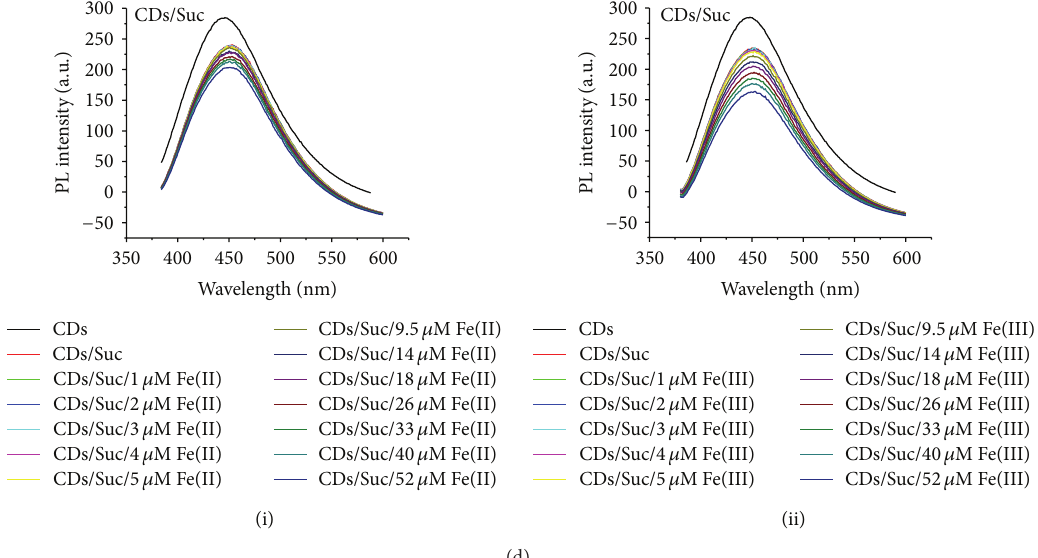
Figure 4: Photoluminescence emission spectra of (a) CDs at different concentrations of (i) free Fe(II) and (ii) free Fe(III), (b) CDs/ 𝛽 -cd at different concentrations of (i) free Fe(II) and (ii) free Fe(III), (c) CDs/LMH at different concentrations of (i) free Fe(II) and (ii) free Fe(III), and (d) CDs/Suc at different concentrations of (i) free Fe(II) and (ii) free Fe(III).